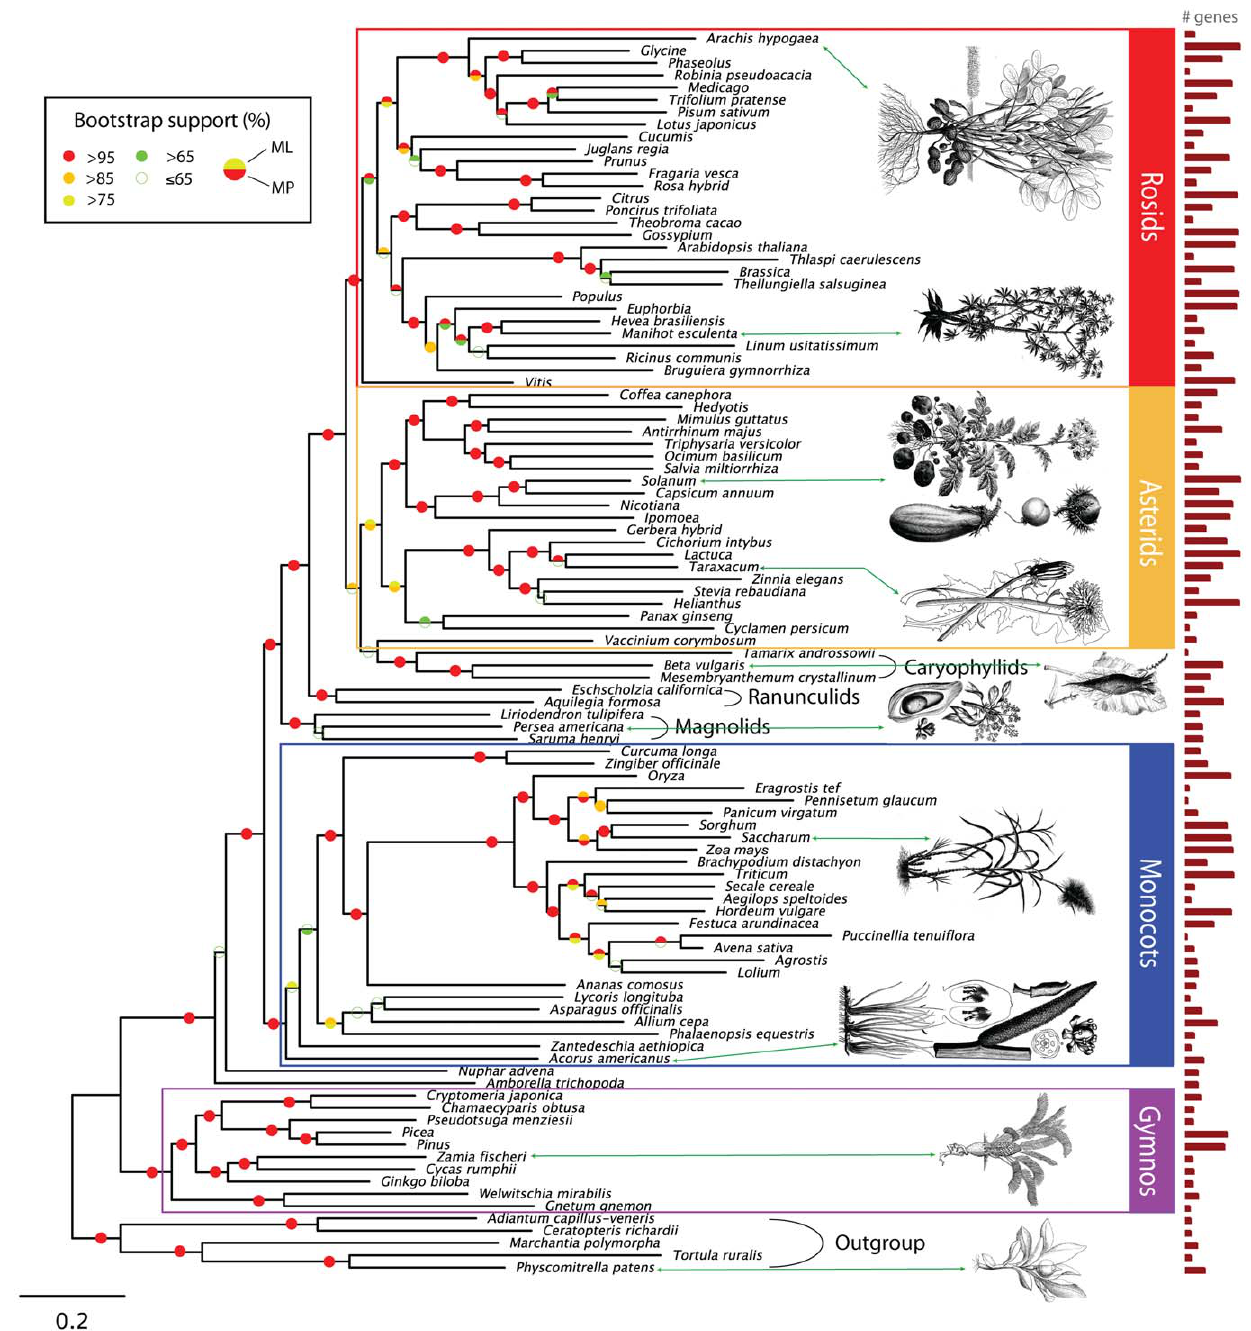
Figure 1. Maximum Likelihood Phylogram of the Genus-Only Alignment of 101 Taxa with at Least 30% Representation per Partition (ML-30) Using the GTR Substitution Matrix and the CAT Model of Among-Site Rate Heterogeneity. Taxon with genus-only label represents multiple species of the same genus. ML and MP bootstrap support percentages are color-coded. ML node values indicate the percentage of rapid bootstrap pseudoreplicates containing the nodes of the best ML tree. MP values correspond to the bootstrap proportions on the 50% majority-rule consensus tree. The red bars represent the relative number of genes per species represented in this matrix. The most-represented species in the full matrix (with respect to number of genes) is Glycine max (10,071 genes), and the least-represented species is Puccinellia tenuiflora (173 genes; see Table S1). The median number of gene partitions in which a taxon is represented is 2,071. This ML-30 tree has 101 taxa (genera), derived from 2,970 gene partitions and 1,660,883 characters. Outgroups include the ferns, Adiantum and Ceratopteris ; the mosses Physcomitrella and Tortula ; and the liverwort, Marchantia . The estimated GTR substitution matrix is provided in Table S5. doi:10.1371/journal.pgen.1002411.g001 convergent in conifers plus Gnetales and in the angiosperms, as an plesiomorphy (Figure S6B). Perhaps the most interesting aspect independently derived apomorphy. In this case, motile male of these reversed character optimizations is that with the Gnetales gametes in cycads and Ginkgo would be a gymnosperm sister to the rest of the gymnosperms as in our phylogenomic tree,